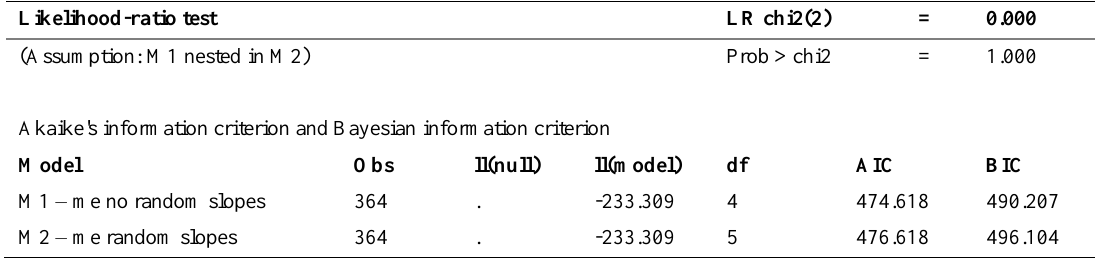
Table 4: LR test on the effect of reliability as level-2 random